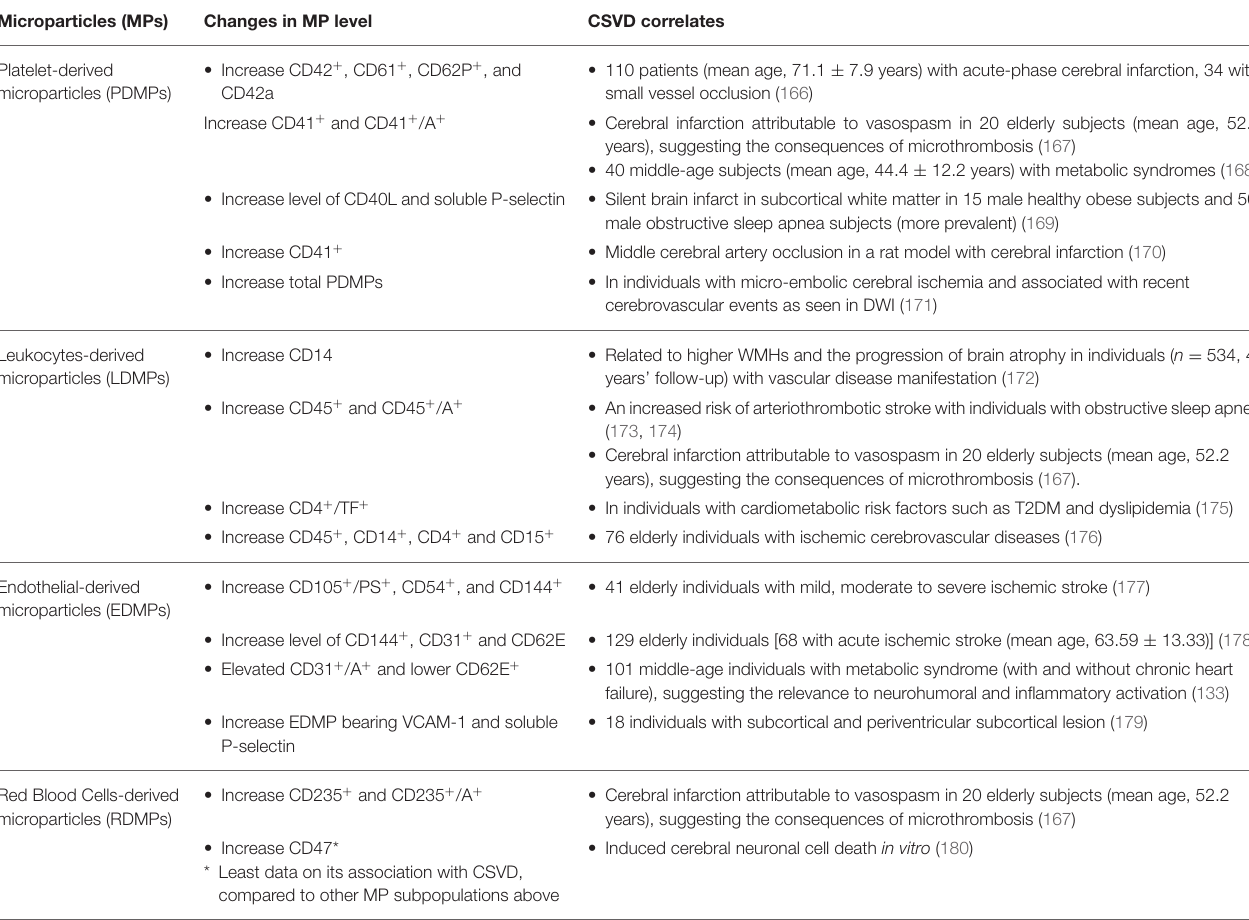
TABLE 3 | Microparticles (MPs) subpopulation, their surface markers and CSVD correlates. Microparticles